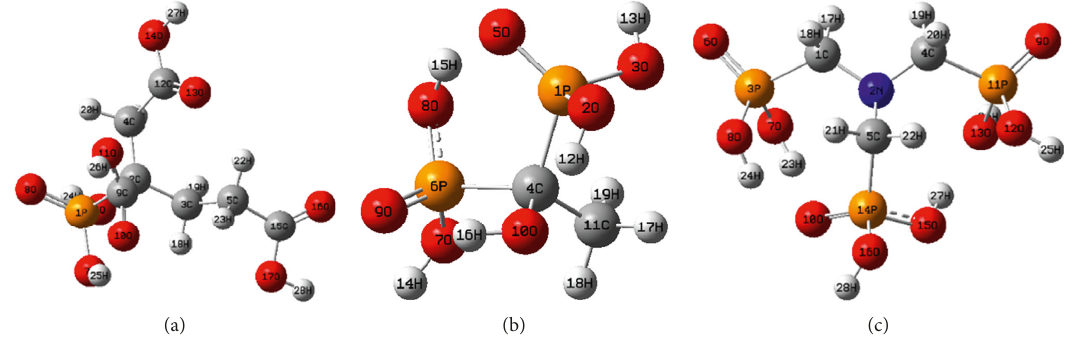
Figure 1: Molecular model diagram of three organophosphorus inhibitors. (a) PBTCA. (b) HEDP. (c) ATMP.